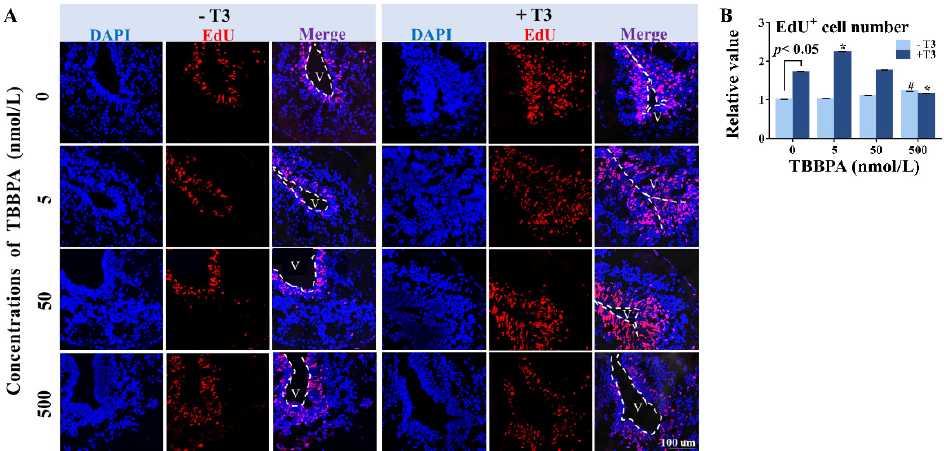
Figure 4. EdU-labeled cell proliferation in telencephalons of pre-metamorphic Xenopus laevis following 4-day exposure to tetrabromobisphenol A (TBBPA) in the absence or presence of 1 nmol/L T3. ( A ) Immunofluorescence images of telencephalons at the end of the T3-induced metamorphosis assay. EdU label (red) and DAPI (blue). ( B ) The ratio of EdU positive cells number. Three animals were analyzed for each treatment. V: ventricle. Parameter was normalized by the mean value of the solvent control. Data are shown as mean ± SD. # indicates significant differences between TBBPA treatment and solvent control treatment ( p < 0.05). * indicates significant differences between TBBPA + T3 treatment and T3 treatment ( p < 0.05).